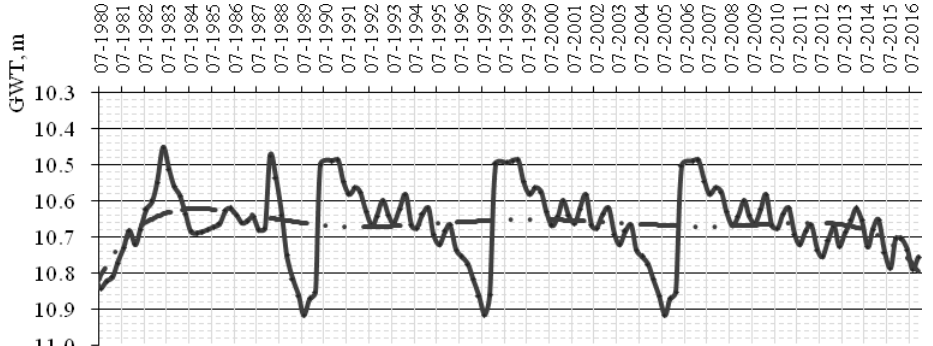
Figure 8. Fluctuations of seasonal average GWT (well #263) in the Desna River basin (a tributary of the Dnipro River basin) with a well-defined 8-year cycle.